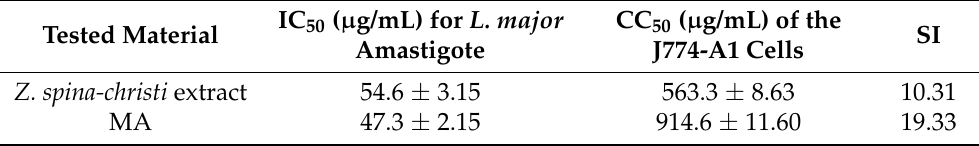
Table 3. The IC 50 and CC 50 values (µg/mL) determined for the Z. spina-christi extract NPs, compared with the MA and their selectivity index (SI) against intramacrophage amastigote forms of Leishmania major .